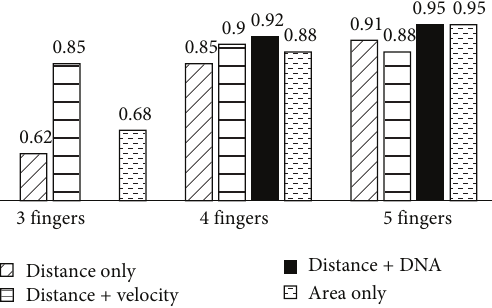
Figure 9: The percentage of successful login rate.